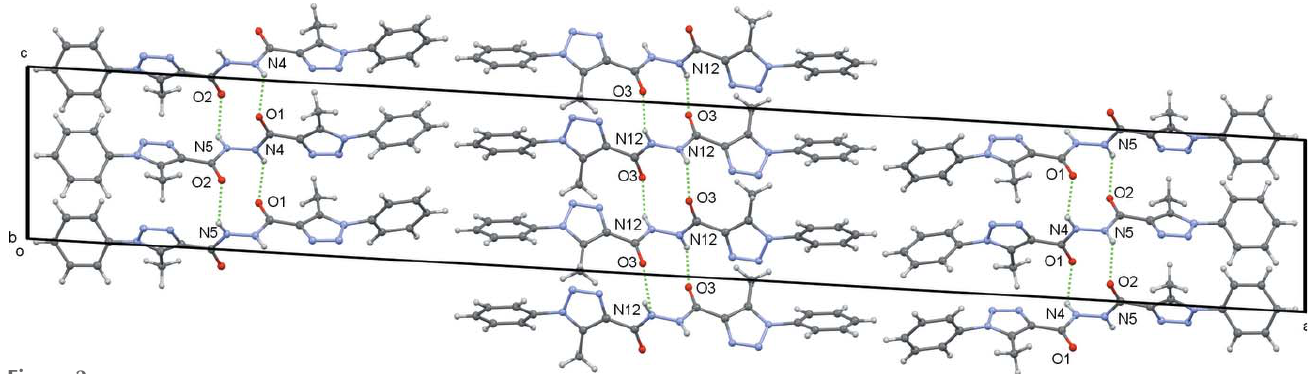
Figure 2 A segment of the crystal structure viewed down the b axis showing N—H (cid:4)(cid:4)(cid:4) O hydrogen-bonding contacts leading to [001] chains.